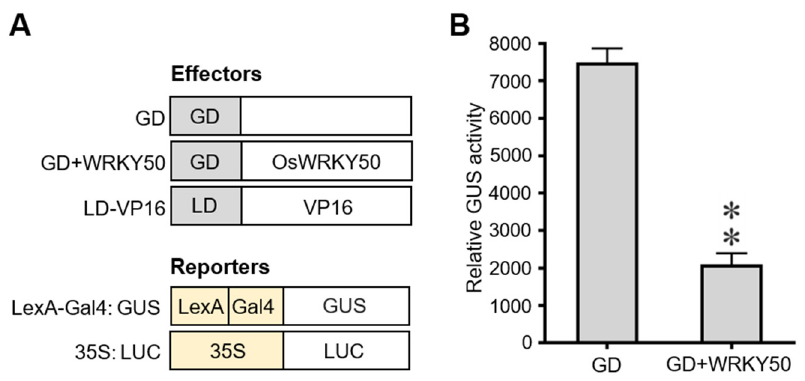
Figure 7. OsWRKY50 shows transcriptional repressor activity in vivo. ( A ) Schematic diagram of GAL4 DNA binding domain (GD) ‐ OsWRKY50 and LexA DNA binding domain (LD) ‐ VP16 fused proteins. ( B ) The relative GUS activity of protoplasts transformed with GD, LD ‐ VP16, and LexA ‐ Gal4:GUS or GD ‐ WRKY50, LD ‐ VP16, and LexA ‐ Gal4:GUS. Protoplasts were isolated from two ‐ week ‐ old rice seedlings. The effector plasmid GD ‐ OsWRKY50 or GD alone was co ‐ transformed